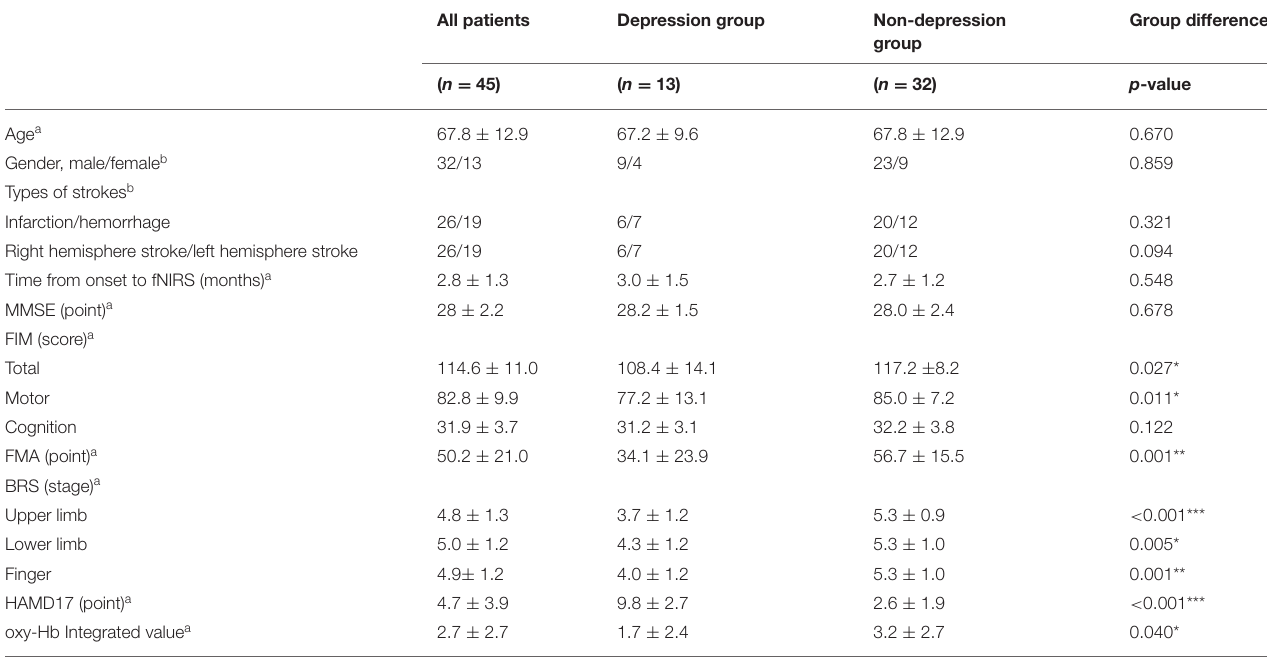
TABLE 1 | Demographic and clinical data of the patients.